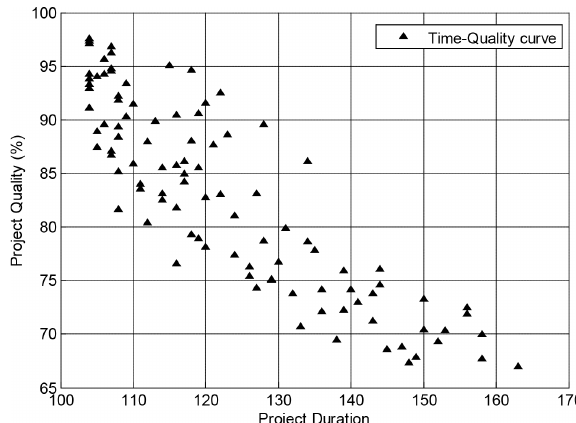
Fig. 10. Time-Quality